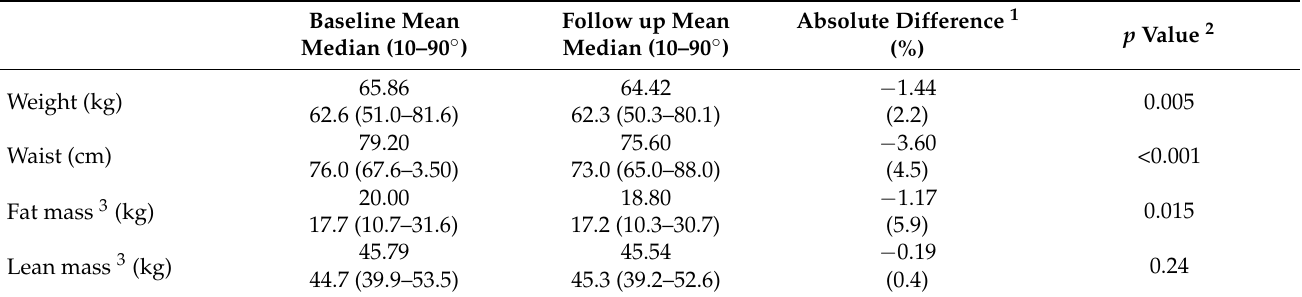
Table 6. Estimated changes in anthropometric measures at the end of the intervention in comparison to baseline (The DAMA25 study, Florence, Italy,